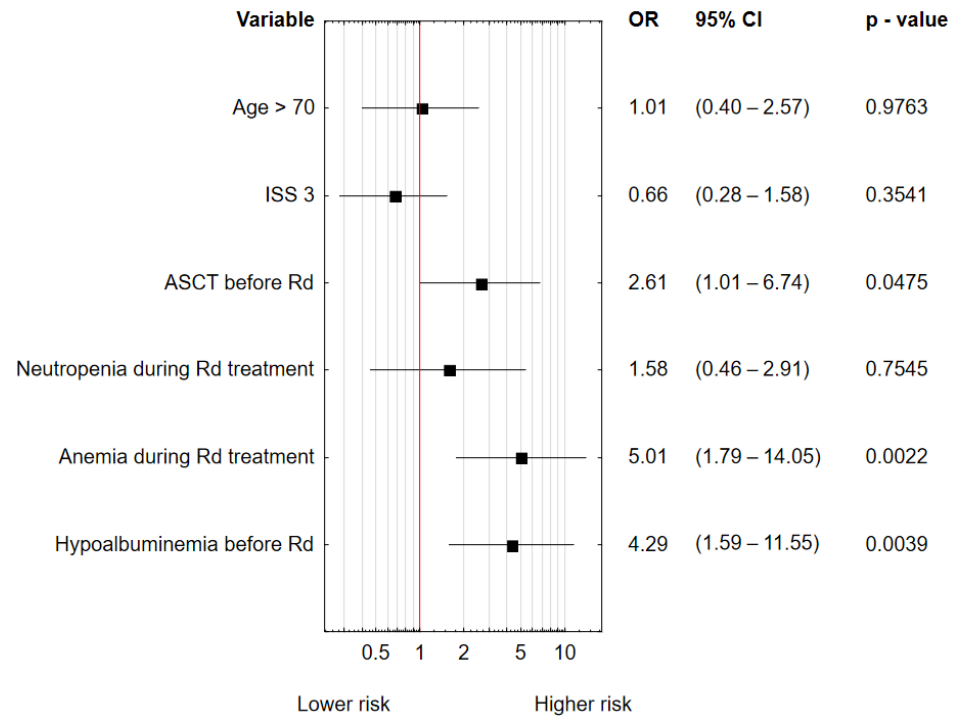
Figure 2. Multivariate logistic regression analysis for infection occurrence during Rd treatment. Table 3. Univariate logistic regression for infection during Rd treatment.